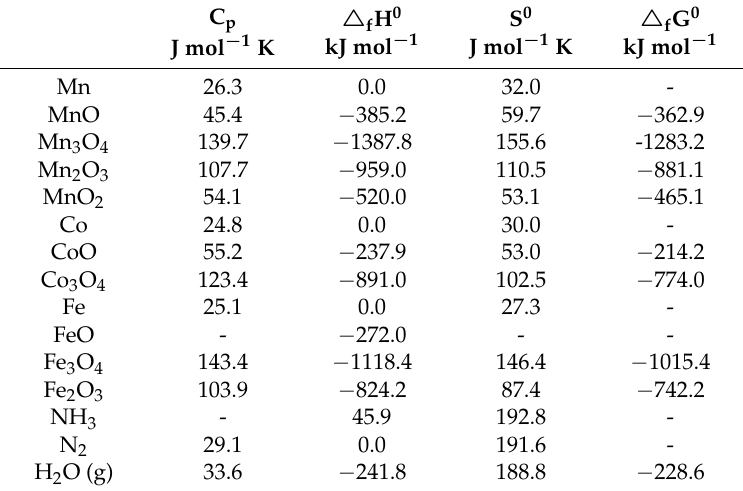
Table 6. Standard thermodynamic properties of M x O y